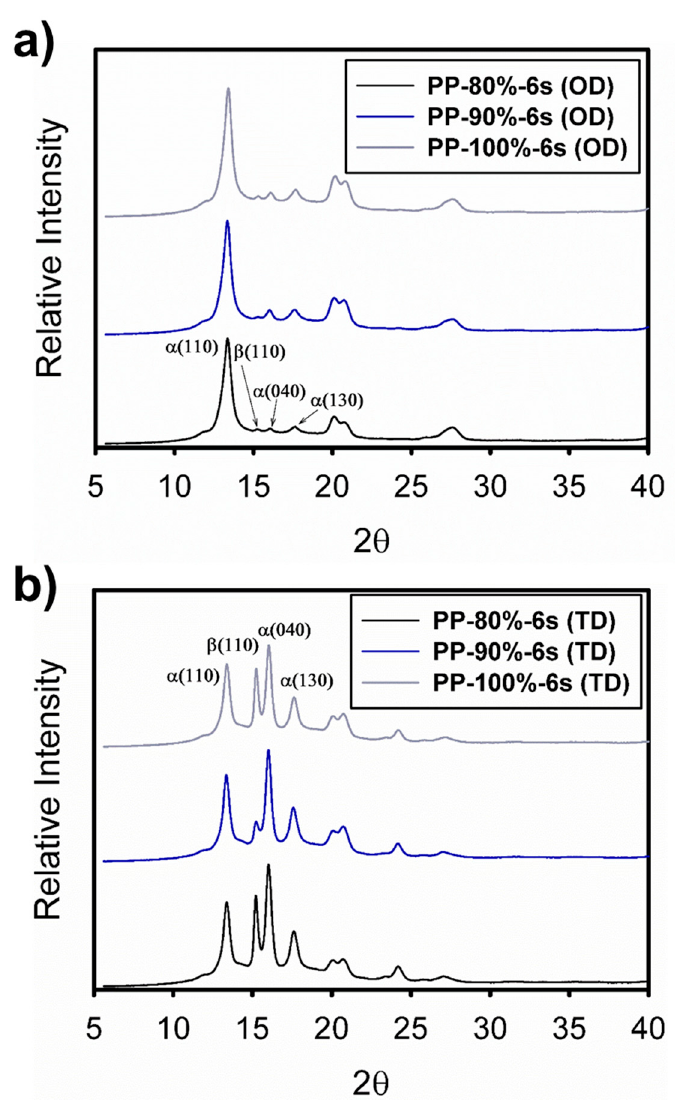
Figure 7. 1D WAXS patterns of the iPP probes injected at constant ultrasound time (6 s) and different amplitudes (80%, 90%, and 100%) taken at different orientation directions: ( a ) orientation direction and ( b ) perpendicular or transverse direction directable (110), (040), and (130), and β crystalline phase (300) of iPP are also shown.